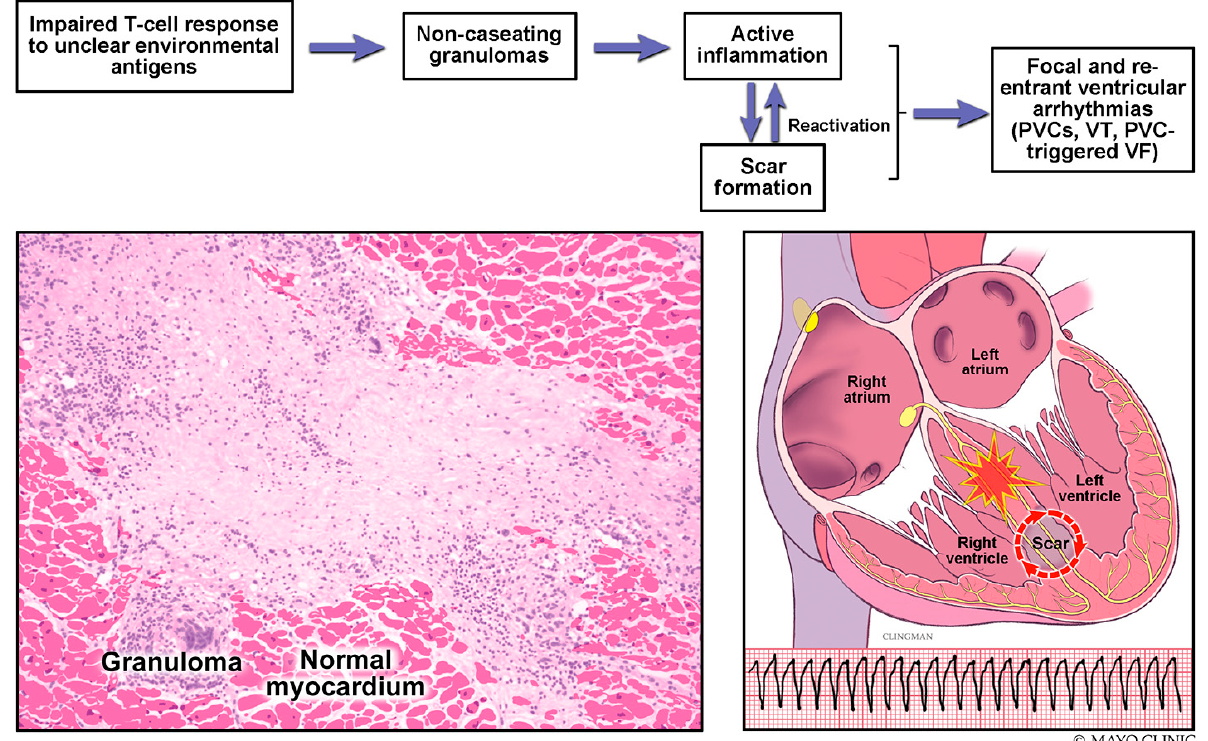
Figure 1. Pathogenesis of sustained ventricular arrhythmias in cardiac